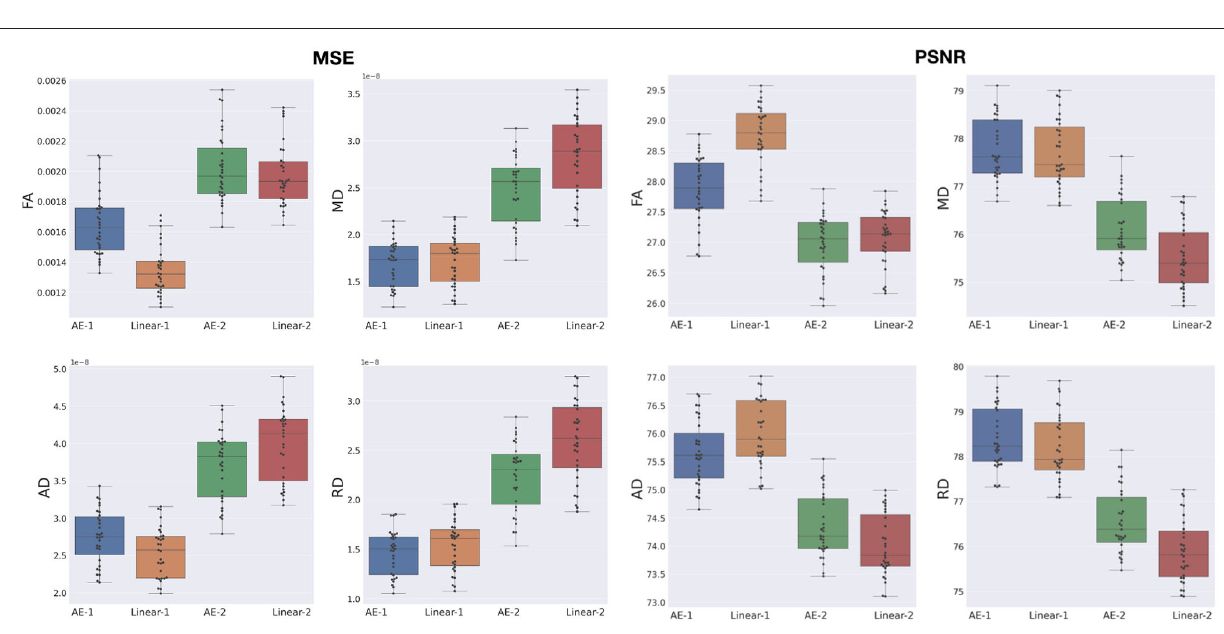
Frontiers in Neurology |